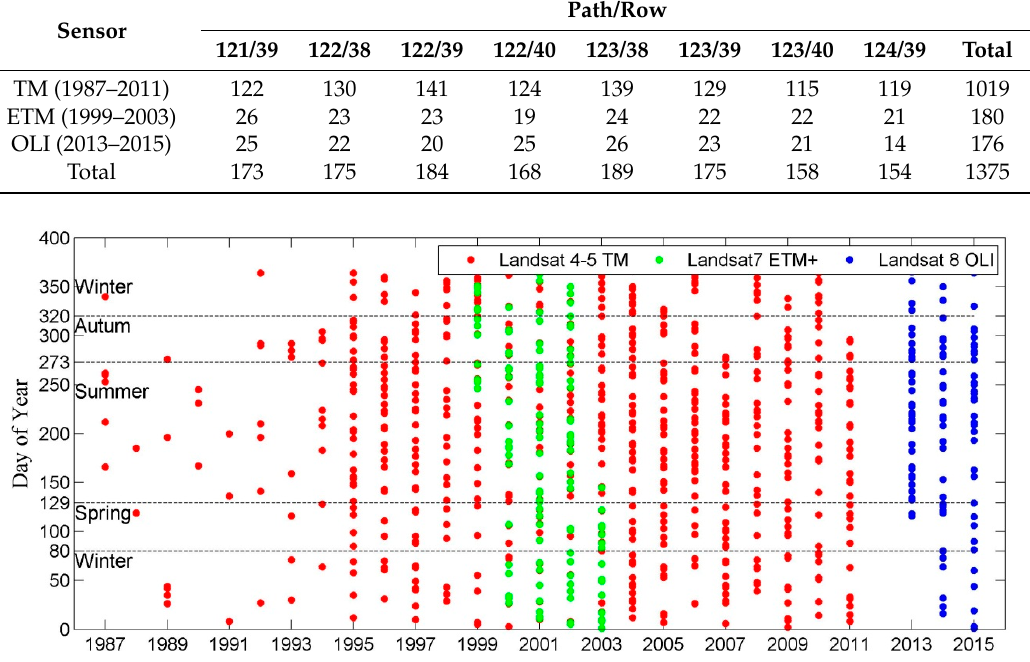
Figure 2. Temporal distribution (day of year) of Landsat images used in this study.